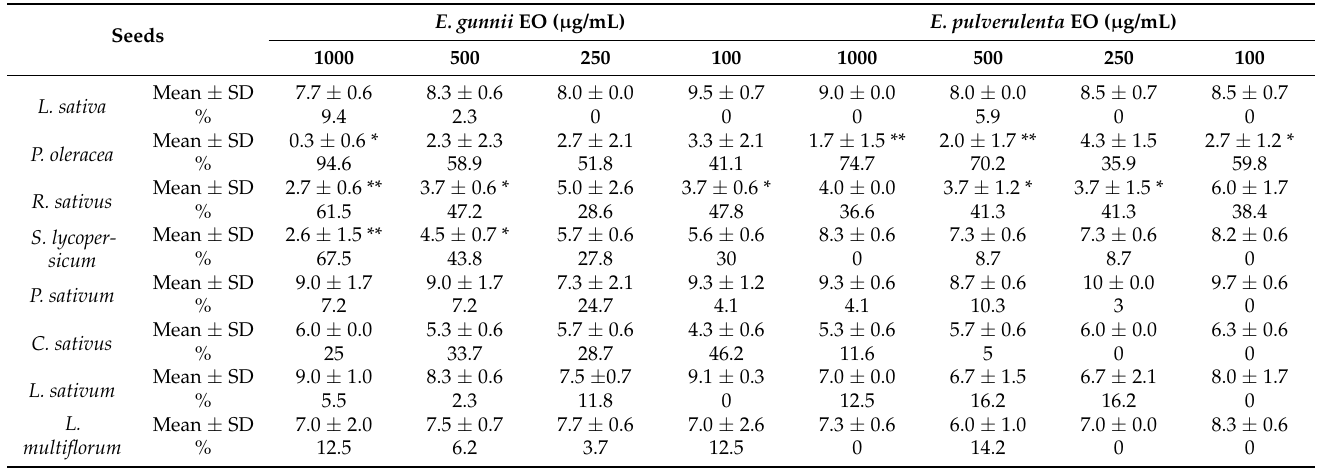
Table 3. Inhibition of germination of L. sativa, P. oleracea, R.sativus, S. lycopersicum, P. sativum, C. sativus, L. sativum, and L. multiflorum seeds treated with different doses of EOs. Results are reported as the mean ± SD of three experiments. * p <0.05, ** p <0.01, vs . control (inhibition = 0), according to two way ANOVA followed by Tuckey’s multiple comparison test, at the significance level of p < 0.05.